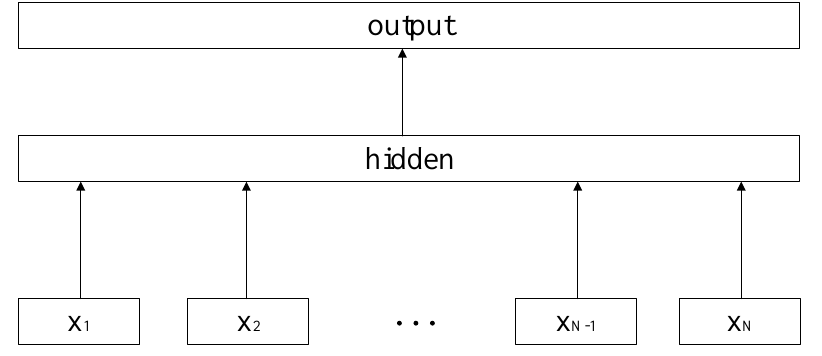
Figure 1. Model architecture of FastText for a post with N n-gram features x 1 ,..., x N . The features are embedded and averaged to form the hidden